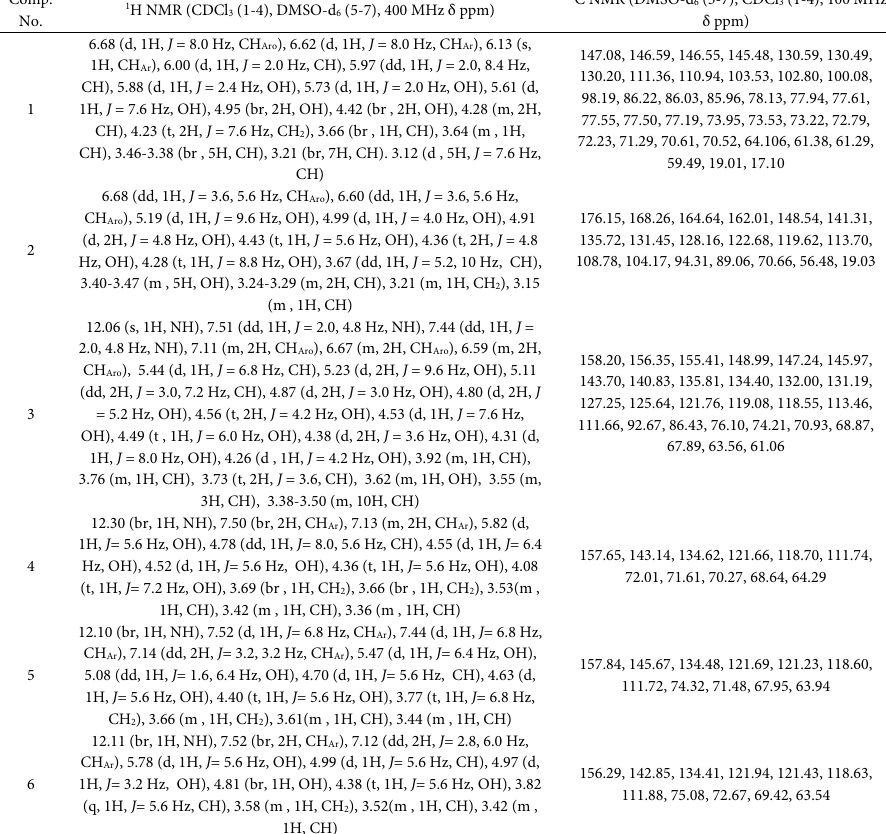
Table 5. NMR spectral data for compounds (1-6)